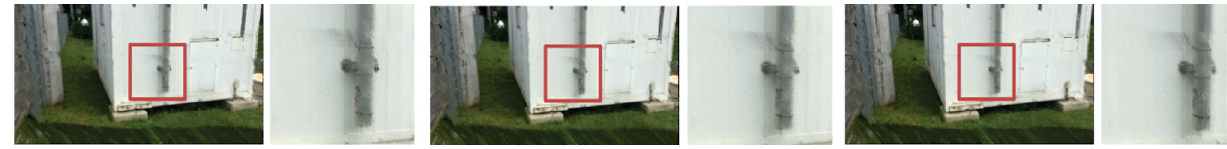
Fig. 10 Background restoration for consecutive frames of Scene 3.